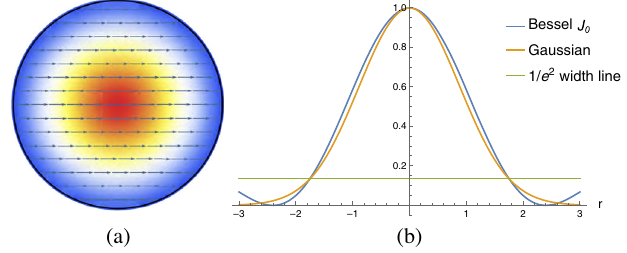
FIG. 11. (a) Transverse electric field stream lines and amplitude strength for the dominant hybrid mode ( n ¼ 1 , j ¼ 1 ) of the iris line at high-frequency operation (overmoded) above cutoff ( k 0 ≈ β ), based on Eqs. (A25) and (A26). This mode is promising for direct coupling with radiation from a THz linear undulator at LCLS. (b) A comparison between the intensity profiles of the Bessel function J 2 0 ð r Þ and the Gaussian e − r 2 = σ 2 , where σ is the amplitude rms